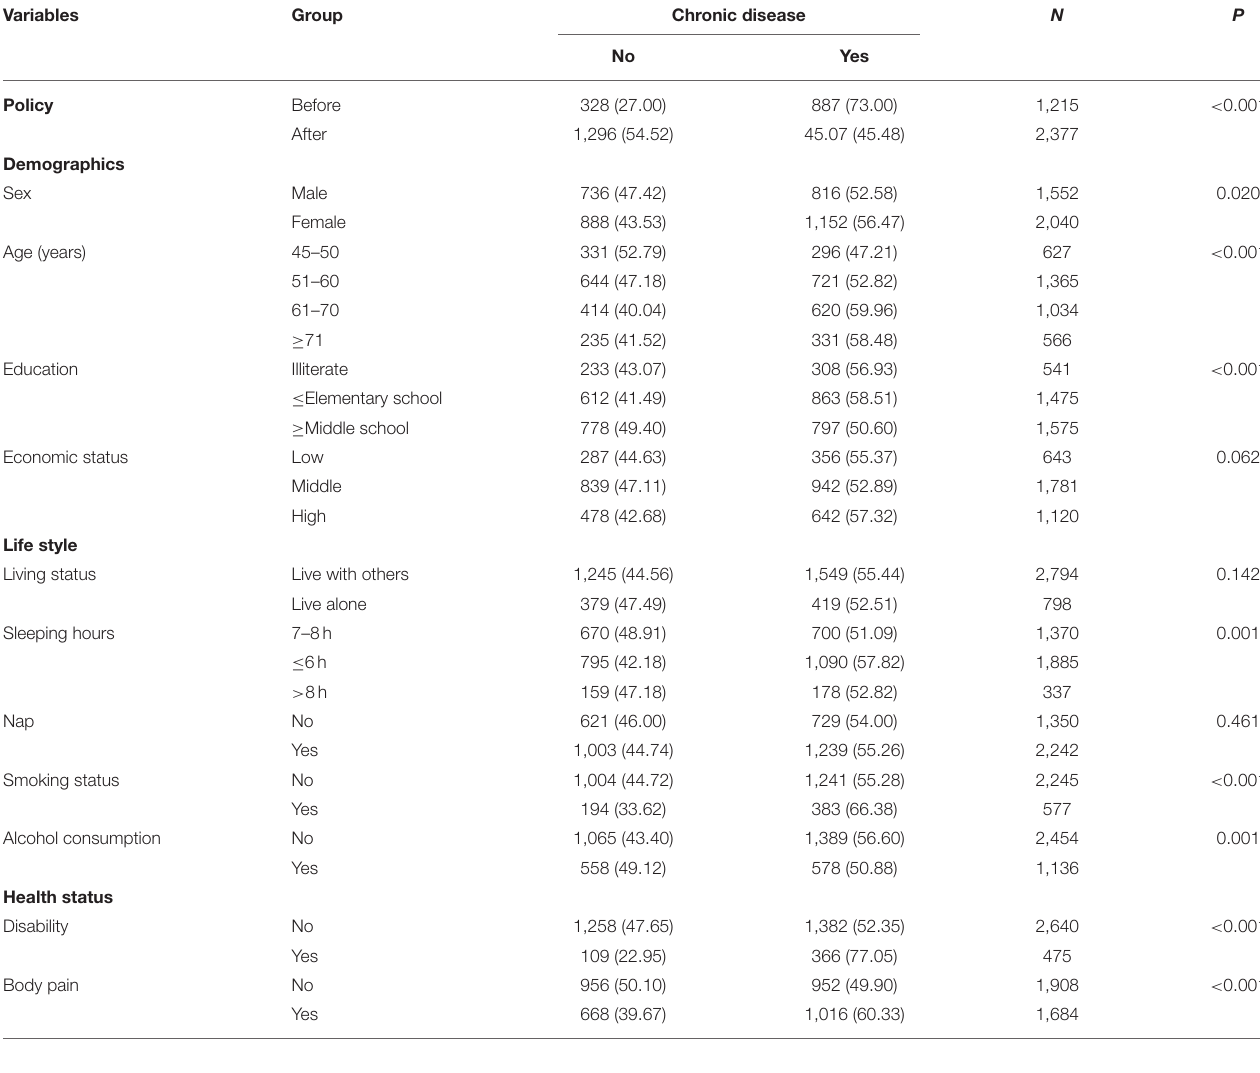
TABLE 4 | Distribution of chronic disease rate among urban participants ( n = 3,592). Variables